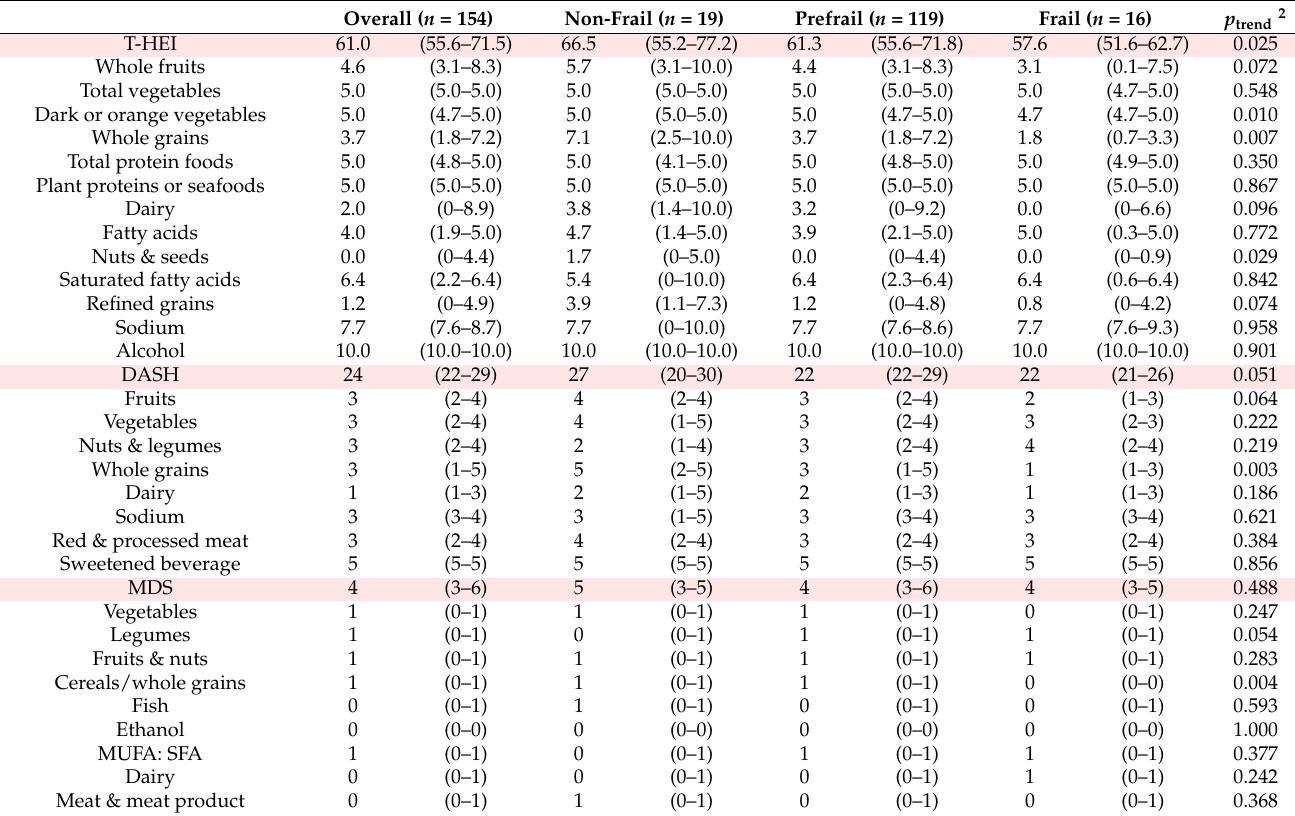
Table 3. Median (IQR) distribution of dietary quality total and components scores for overall participants and across frailty status 1